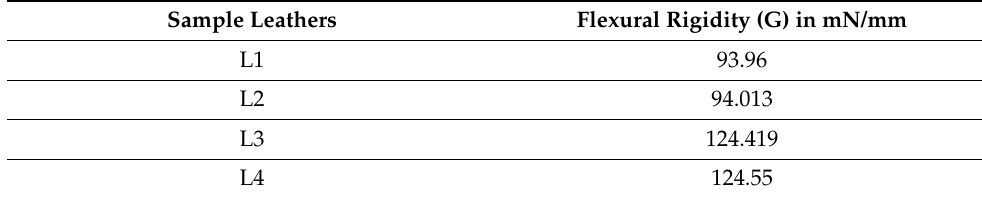
Table 3. Flexural rigidity of sample